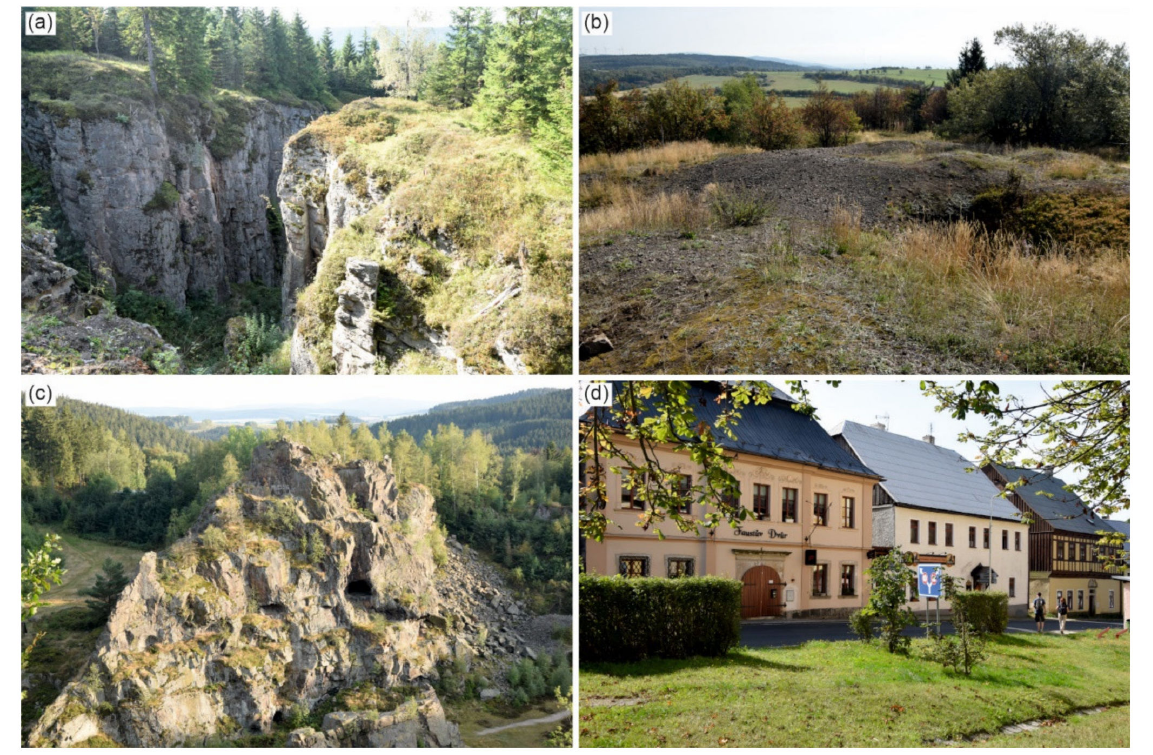
Figure 4. Mining heritage of Erzgebirge/Krušnohoˇr í Mining Region—a transboundary UNESCO World Heritage property in Czechia/Germany. ( a ) evidence of exploitation of ore-bearing veins near the town of Horn í Blatna, Czechia, ( b ) waste heaps and terrain depressions after collapsed shafts on Mt. Mˇednik, Czechia, ( c ) remnants of a large tin mine in Geyer, Germany, ( d ) preserved traditional buildings of an old mining town, Horn í Blatna, Czechia (all photographs by the